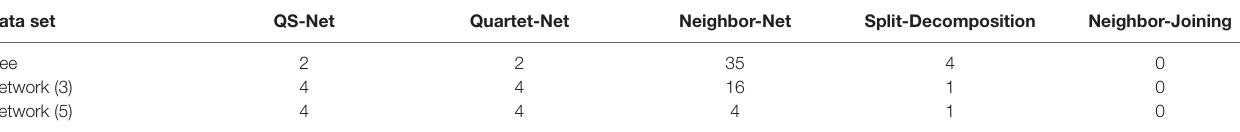
TABLE 3 | The number of false-positive results obtained by five methods.